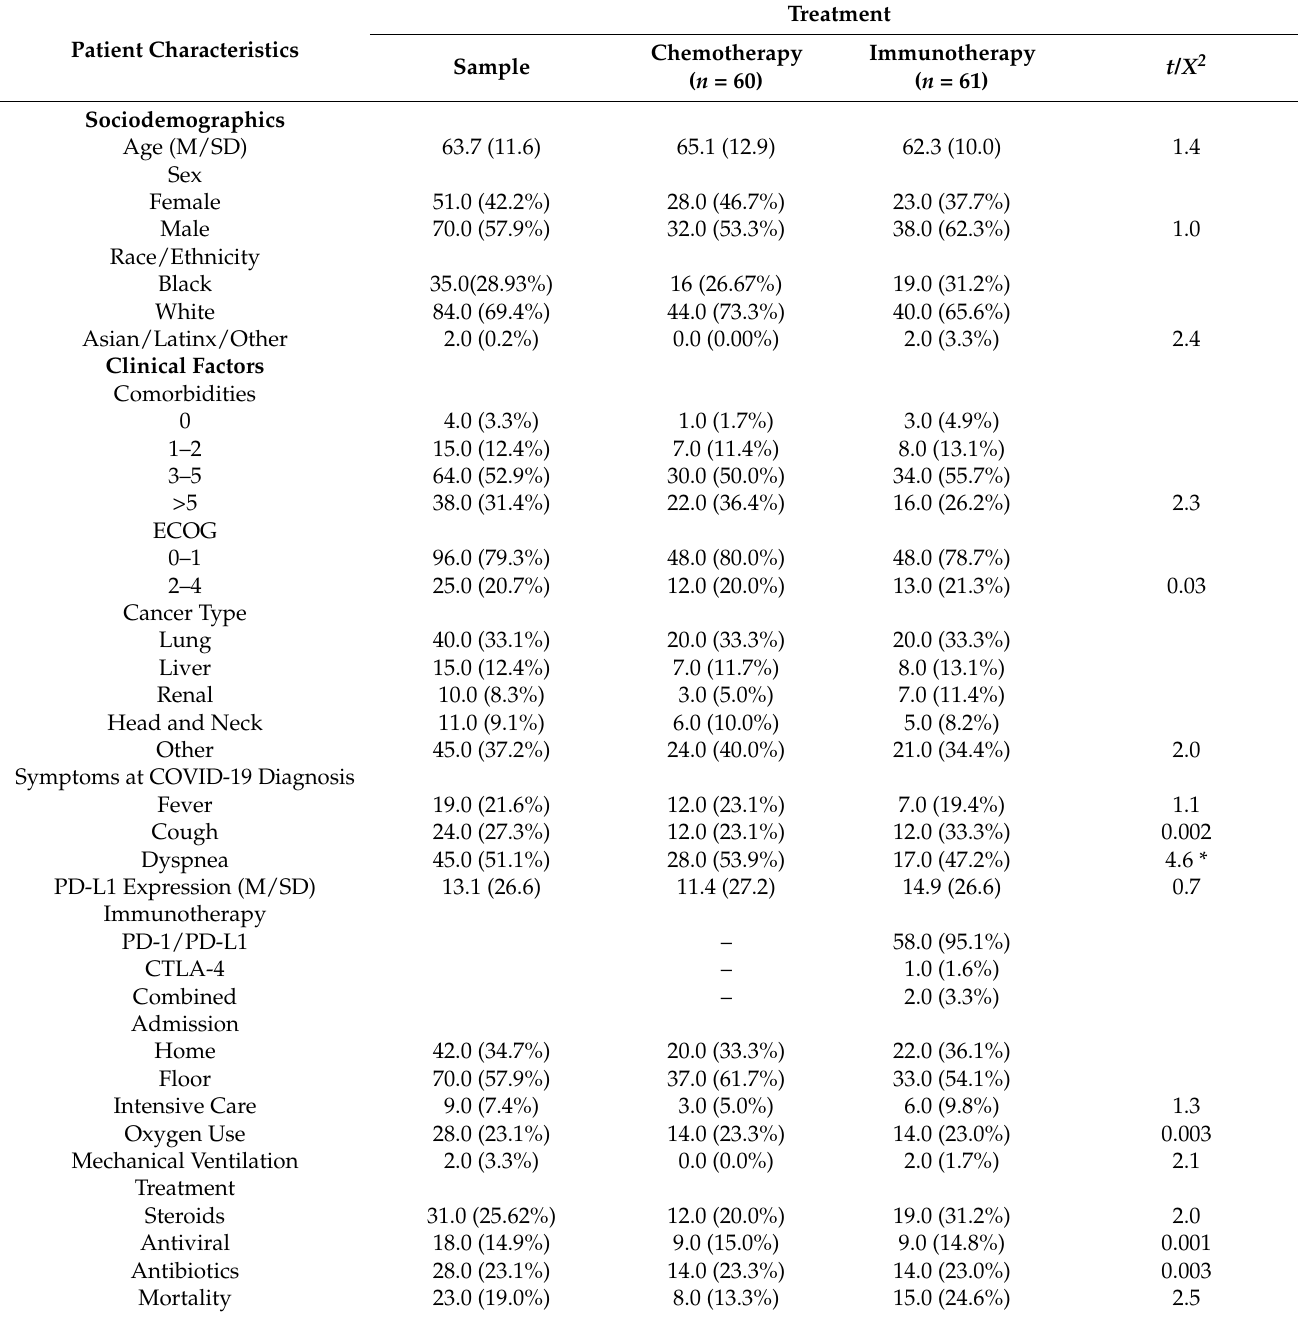
Table 1. Characteristics of the sample, COVID-19 infection, all cancers ( n =